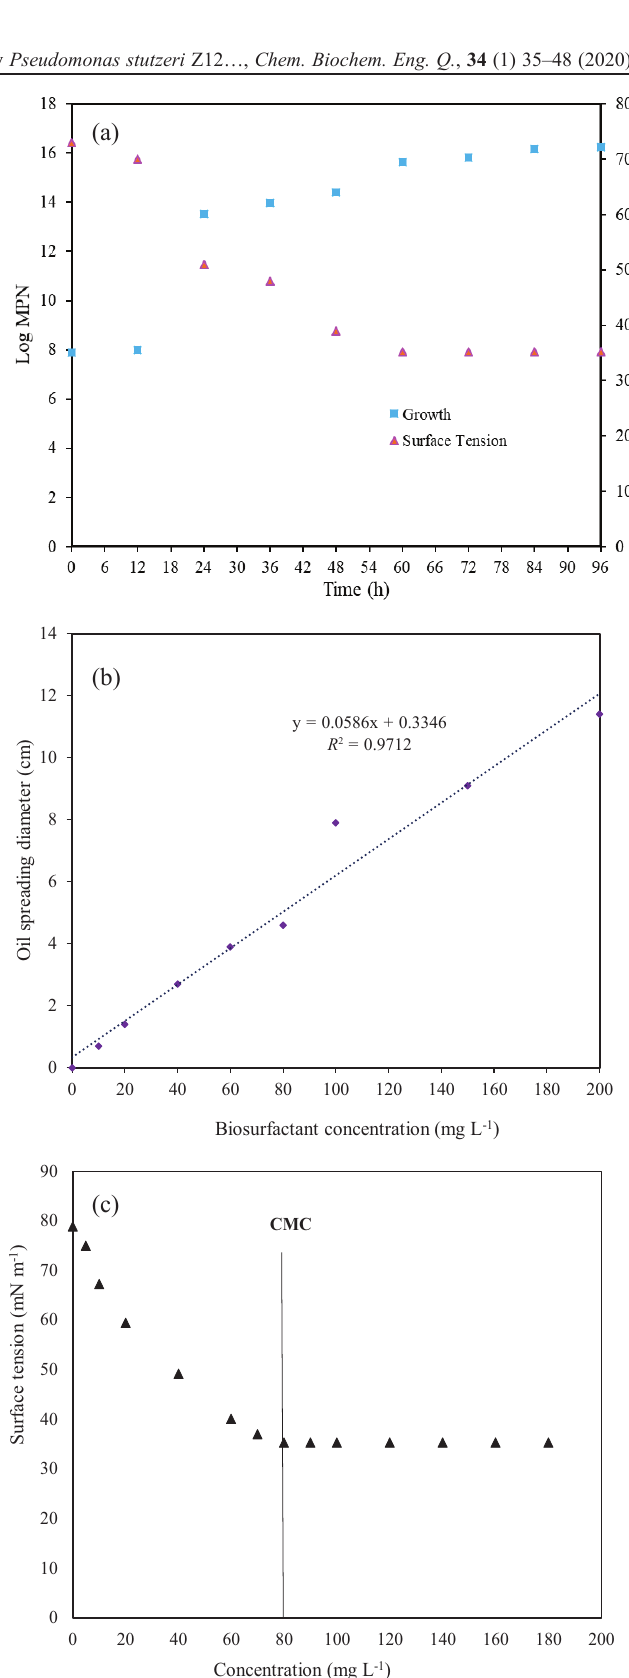
Fig. 3 – Results of a, b) oil spreading test, and c) the blood agar test for initial screening of biosurfactant production by Pseudomonas stutzeri Z12